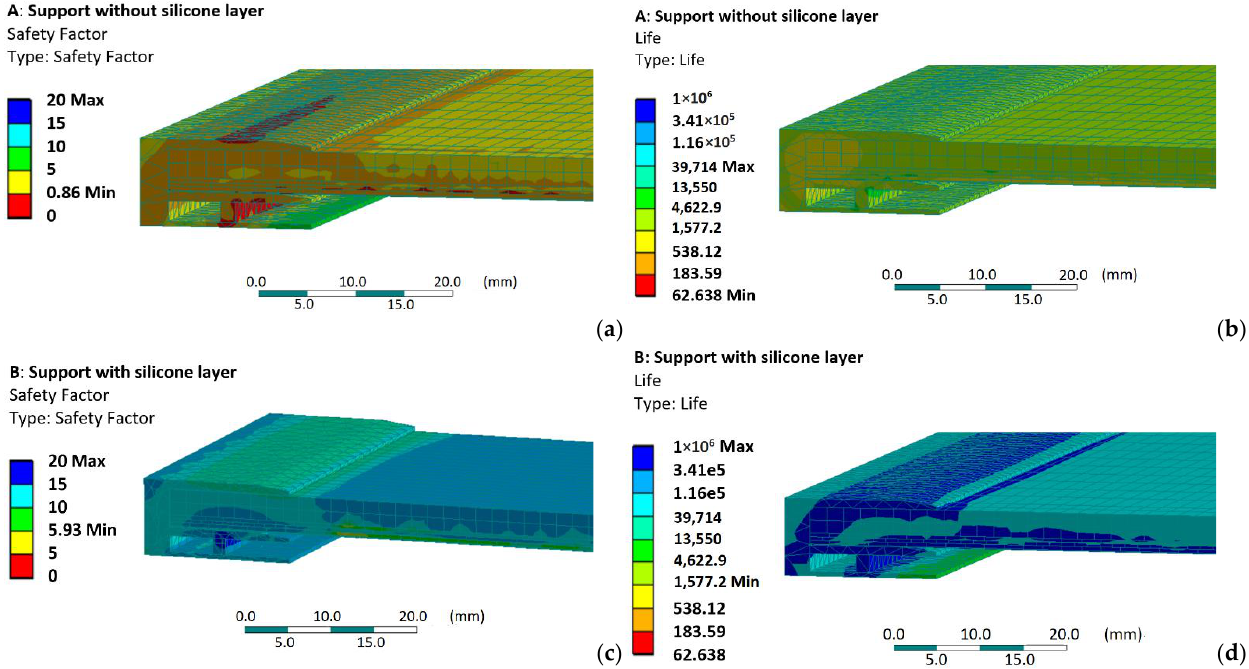
Figure 16. ( a ) Safety factor without silicone layer; ( b ) Total life cycle without silicone layer; ( c ) Safety factor with silicone layer; ( d ) Total life cycle with silicone layer. The dimensioned drawing of the layer support section with dimensional tolerance in the couplings between the layers and the support is shown in Figure 17, and Figure 18